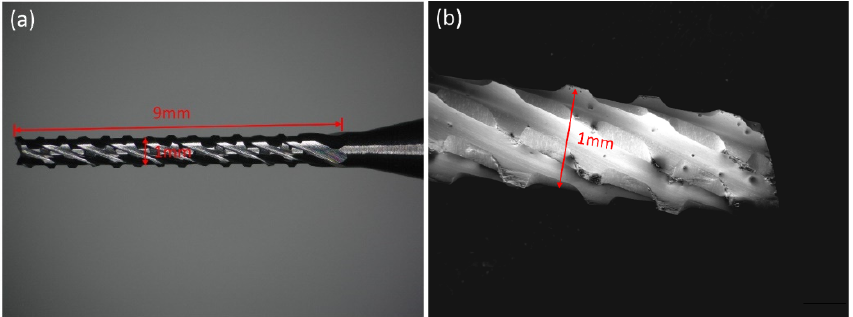
Figure 1. PCB end mills: ( a ) the overall groove of the end mill; ( b ) the partial cutting edge of the end mill.